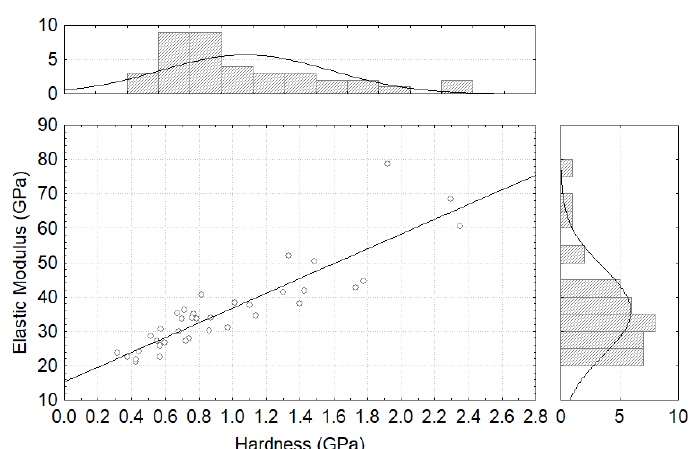
Figure 9. Relation between results of elastic modulus and hardness obtained by the nanoindentation technique for matrices 1 and 2 and